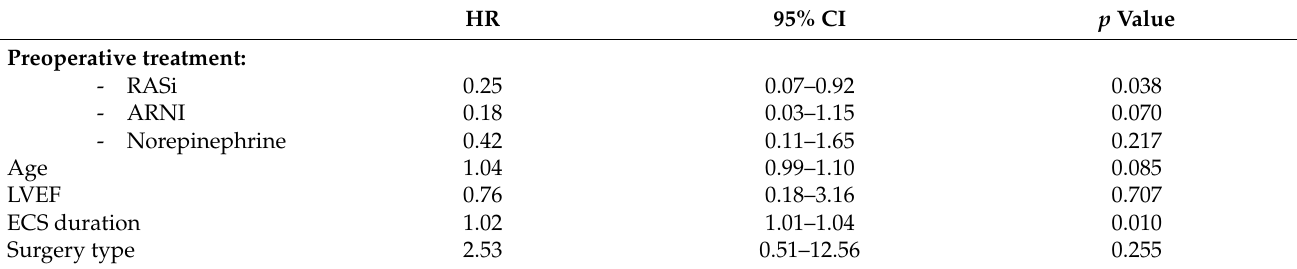
Table 4. Multivariate regression analysis on factors associated with 30-day mortality. 95% CI p